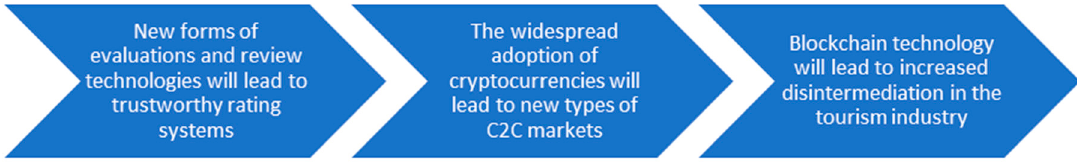
Figure 3. Research proposals [42].